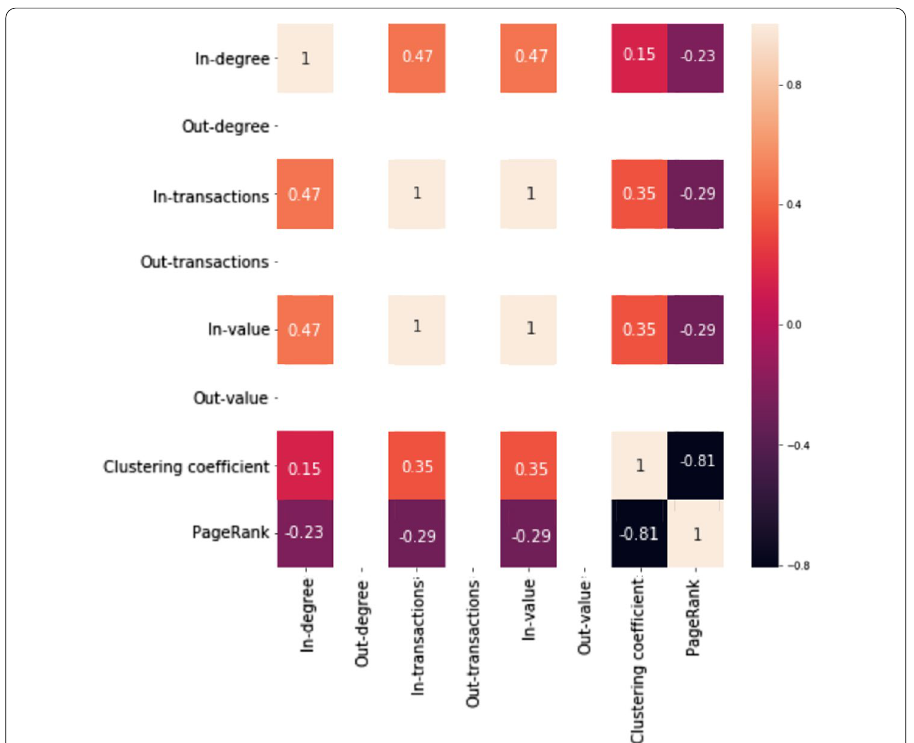
Fig. 5 Correlation matrix for the spectrum features of the class “Token Contract”